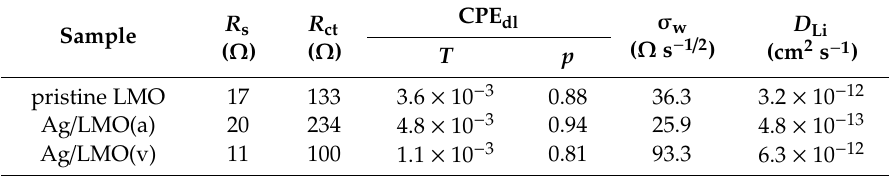
Figure 14. ( a ) Nyquist plots of as-prepared pristine LMO and Ag-coated LMO electrodes; ( b ) equivalent circuit model for EIS fitting; and ( c ) plots of the real part of the impedance vs. ω − 1 / 2 . Table 6. Transport parameters of LMO electrodes deduced from EIS measurements.